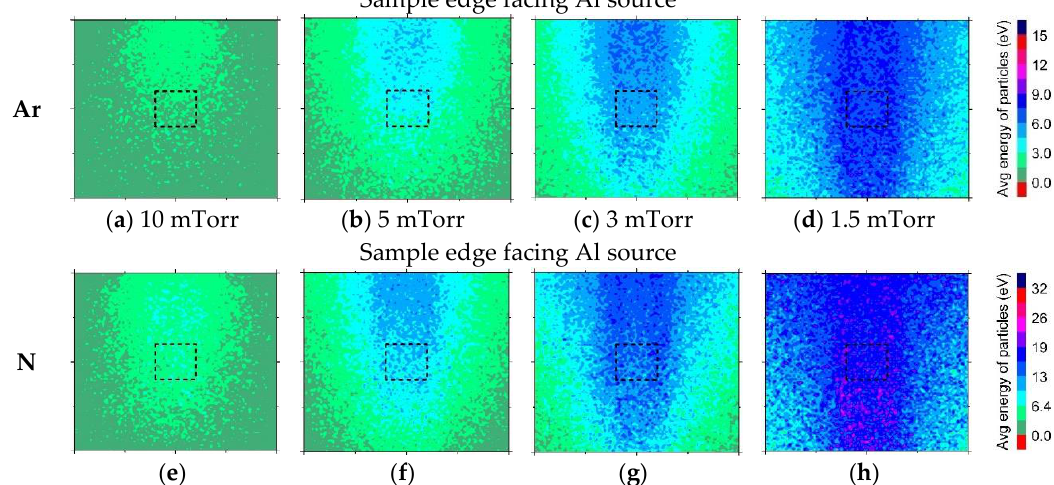
Figure 10. Simulations showing average E P of incoming particles when Al is sputtered using Ar (top) and N (bottom) at 10 ( a , e ), 5 ( b , f ), 3 ( c , g ), and 1.5 ( d , h ) mTorr working pressures in GLAD configuration. The dashed-line square in the maps represents position and (1 × 1 cm 2 ) dimensions of the substrate while the gradient map represents a 5 × 5 cm 2 area to visualize the behavior of the transport of metal flux to and around the substrate. The maps are oriented such that the top edge of the map faces the Al source (not shown) placed 12 cm away from the dashed-line square (substrate).